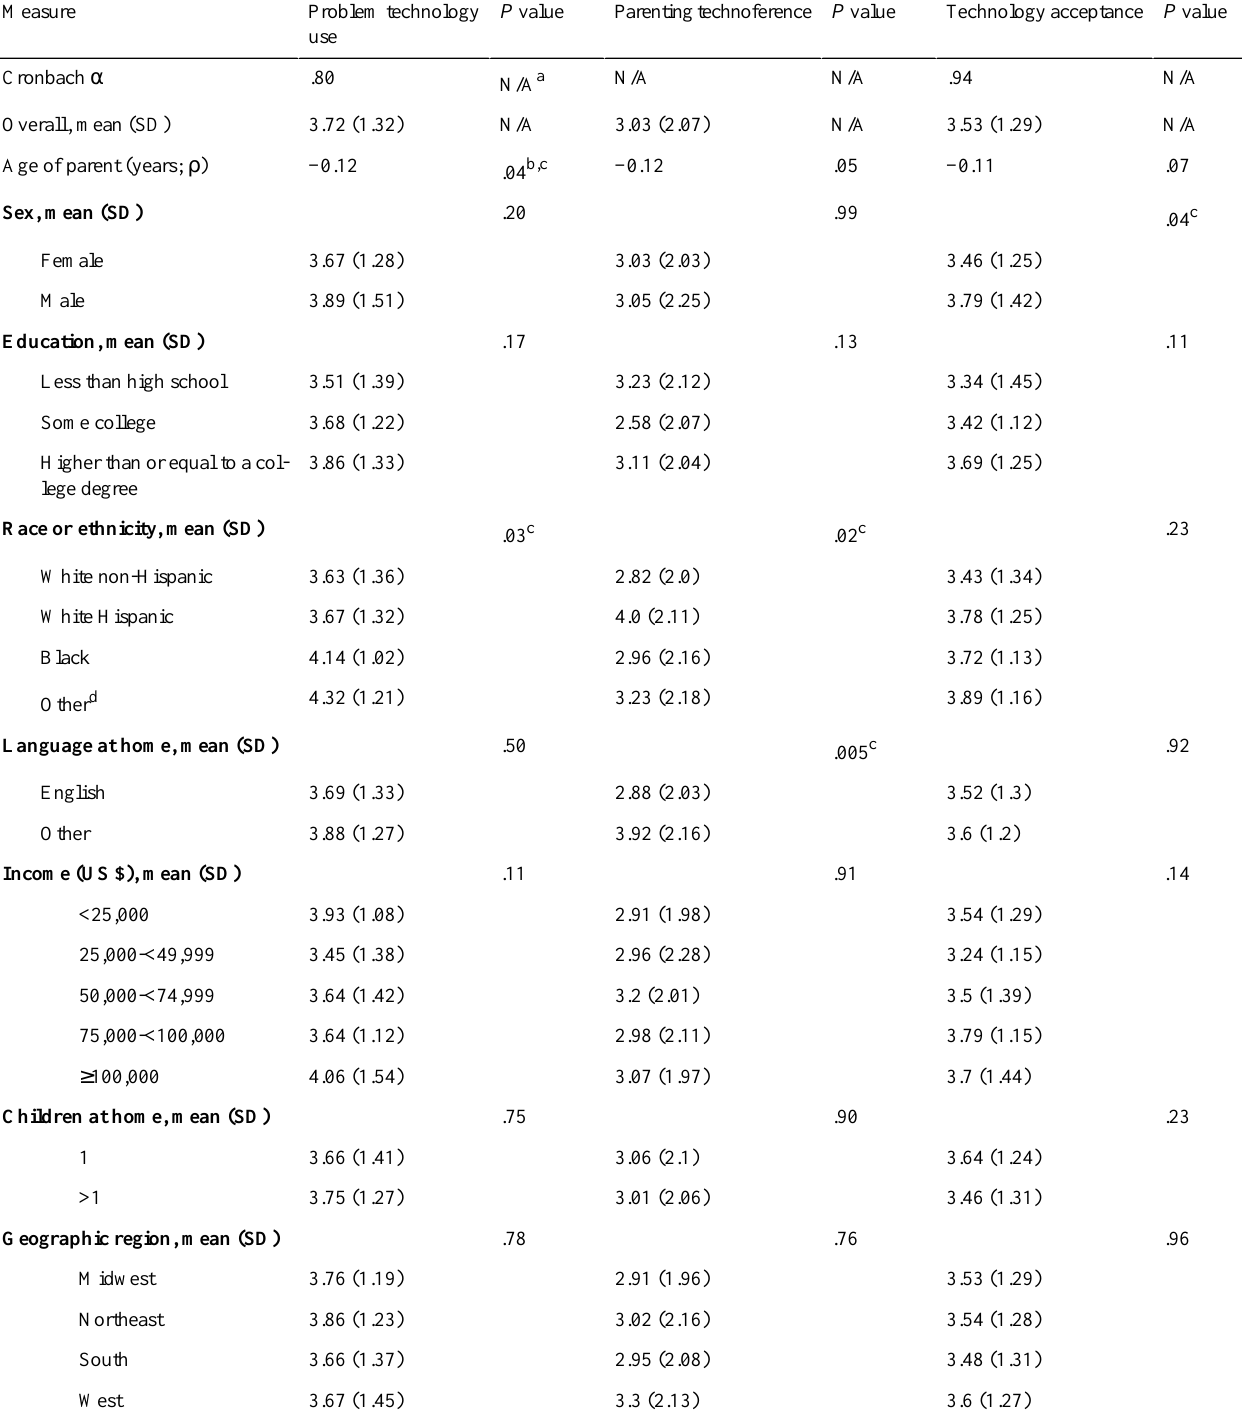
Table 2. Bivariate associations between sociodemographic characteristics and technology acceptance, problem technology use, and parenting